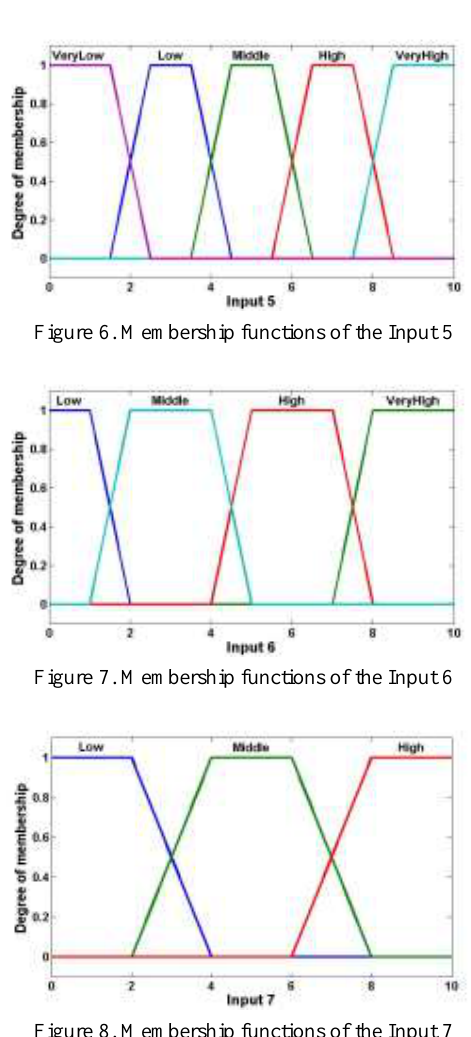
Figure 5. Membership functions of the Input 4